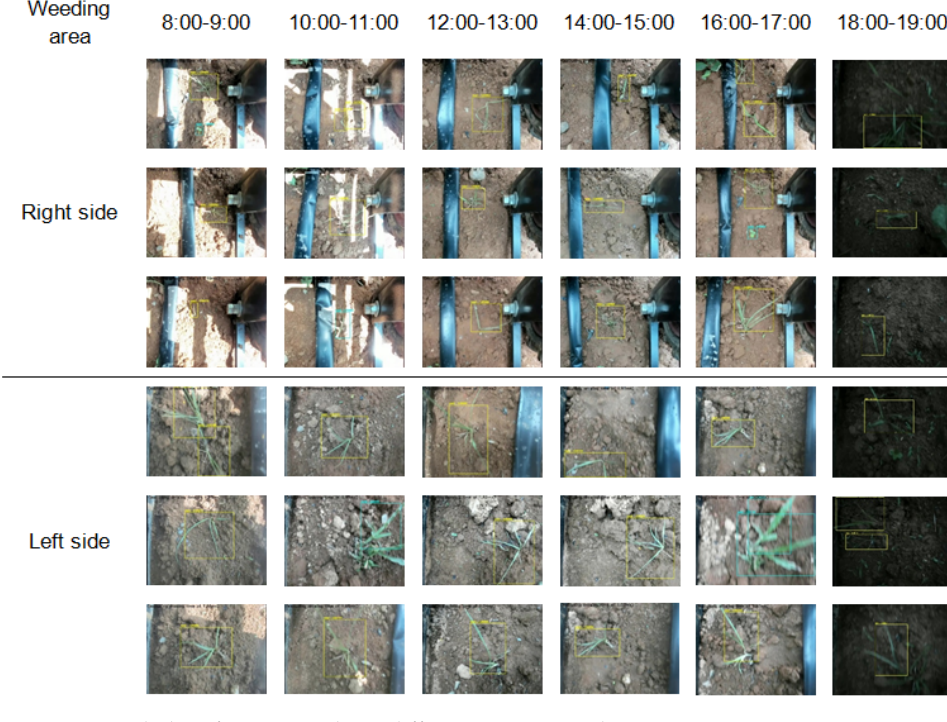
Figure 8. Weed identification results in different time intervals.